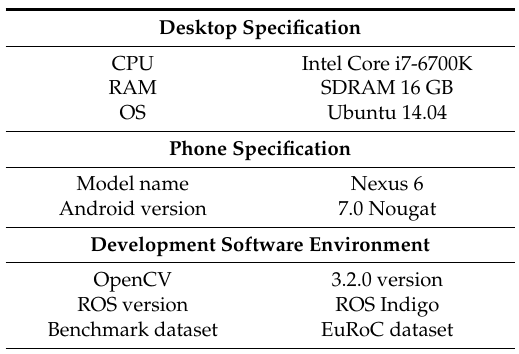
Table 3. Experiment environments.